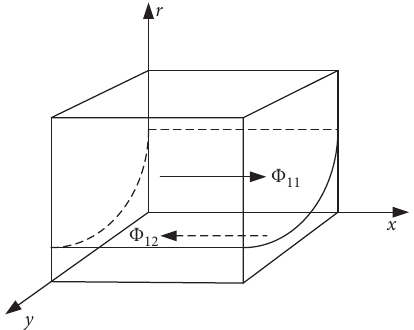
Figure 5: Dynamic evolution of government decision